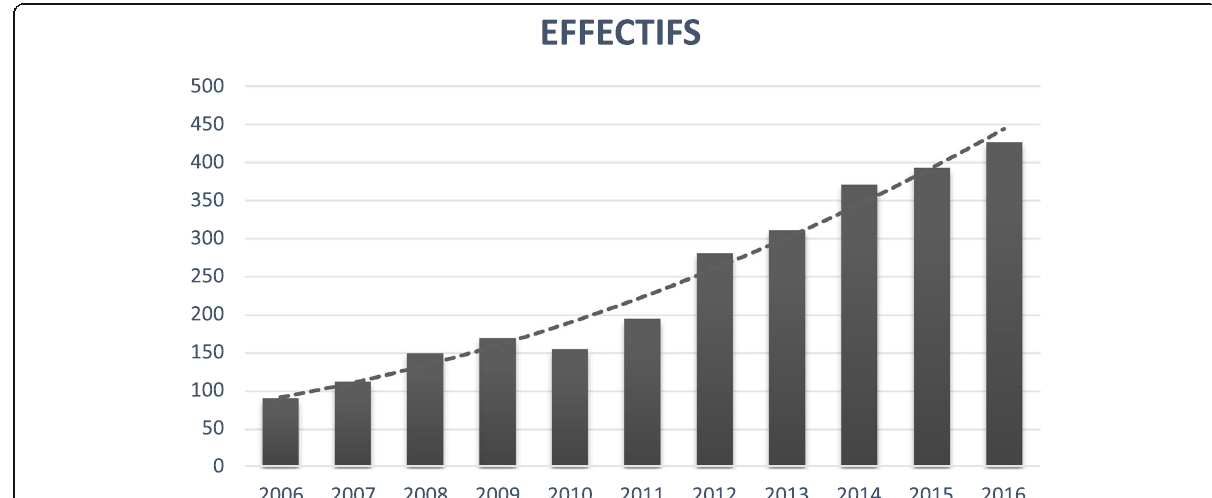
Fig. 2 Annual evolution of the number of schizophrenic patients visiting the psychiatric ward of the Ibn Baja Taza Hospital between 2006 and 2016 ( --- , trend